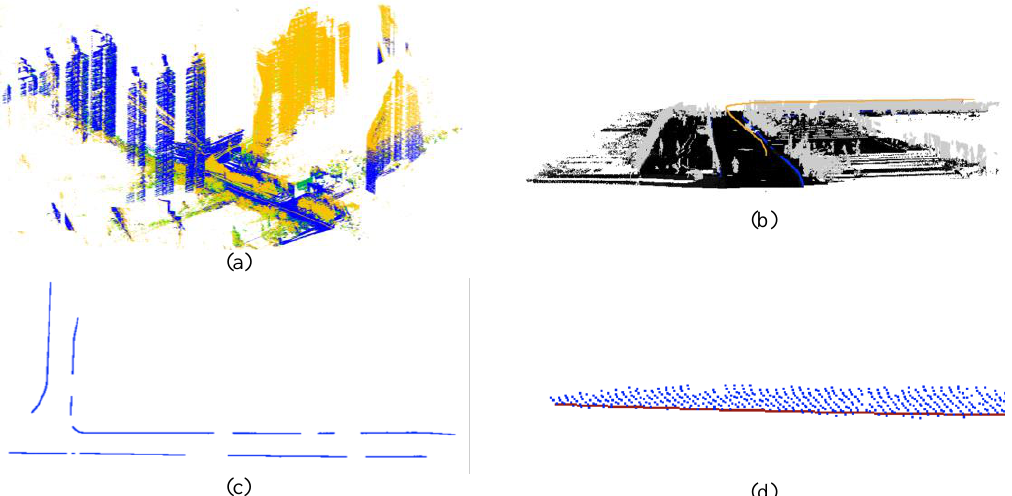
Figure 3. Road boundary extraction result: (a) original point cloud; (b) ground points (black) and off-ground points (gray) below the trajectory (yellow), blue points are curb profiles; (c) extracted curb profiles; (d) magnified view of road curb profiles (blue) and the